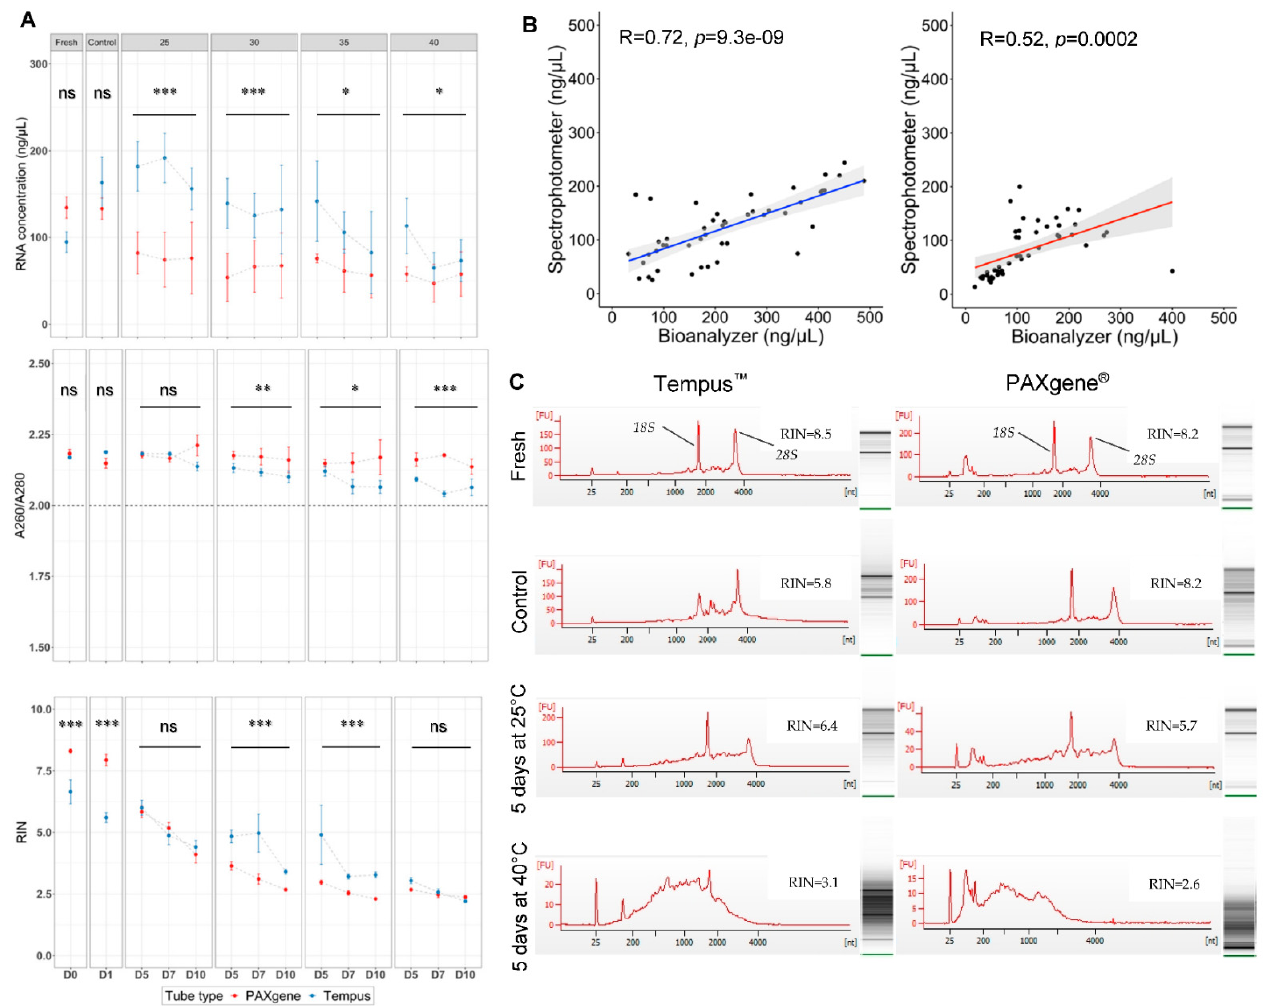
Figure 1. Comparison RNA concentration, purity, and integrity between PAXgene ® and Tempus ™ blood collection systems under suboptimal tropical storage conditions. ( A ) Mean RNA yield normal- ized to whole-blood volume (ng/ µ L), A260/A280 ratios determined spectrophotometrically, and RNA integrity number (RIN) across the different conditions (Fresh ( n = 8), Day1/Control; imme- diately frozen at − 80 ◦ C for later extraction and various temperatures (25, 30, 35, 40 ◦ C) (matched subjects n = 3)). ( B ) Scatter plots revealed correlations between normalized RNA concentration (ng/uL) by Spectrophotometer or Bioanalyzer for PAXgene ® (left panel) and Tempus ™ (right panel). Pearson’s correlation assessed correlations between variables. ( C ) Electropherograms showed two distinct peaks ( 28S and 18S ), gel images showed two bands comprising the 28S and 18S from high- quality RNA, and smears indicated RNA degradation. The uncropped non-quantitative gel per n is shown; 18S and 28S peaks of sample #3 (Fresh) and #2 (Control, 5 days at 25 ◦ C and 5 days at 40 ◦ C). Note the different scales in Figure 1C. The dashed line indicates OD260/A280 = 2.0 for high-quality RNA. Effect of tube type in the linear regression models for each temperature point are indicated; *** p < 0.001, ** p < 0.01, * p < 0.05, ns, non-significant; RIN, RNA integrity